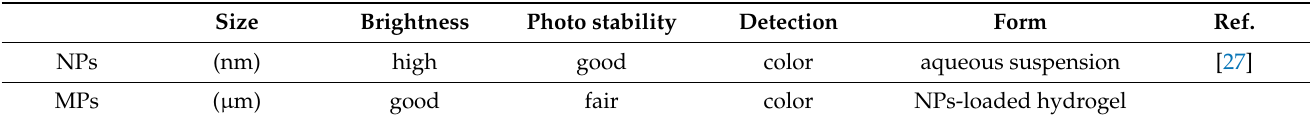
Time (s) Figure 11. Dynamic viscosity versus time in logarithmic scale for CS solution in 2% acetic acid at 25 rpm spindle. 4. Conclusions The paper presents a possible strategy for preparation of fluorescent nanoparti- cle-loaded chitosan hydrogels. The study presents a simple strategy for changing the